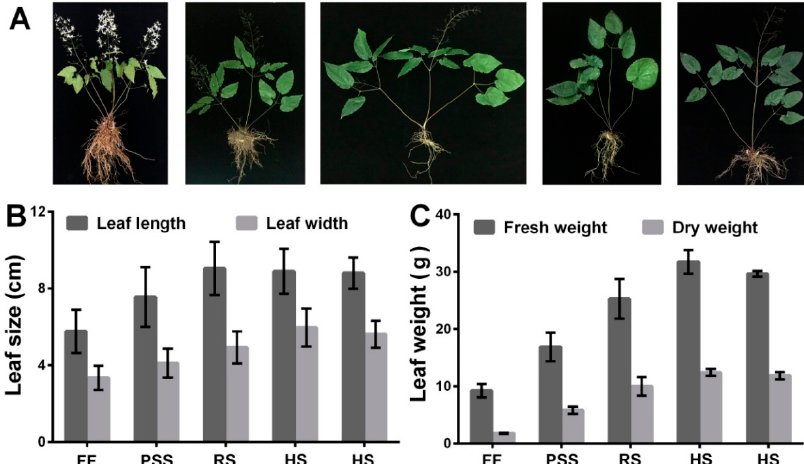
Figure 1. Developmental events of E. pubescens plant ( A ) and changes of E. pubescens leaf size ( B )